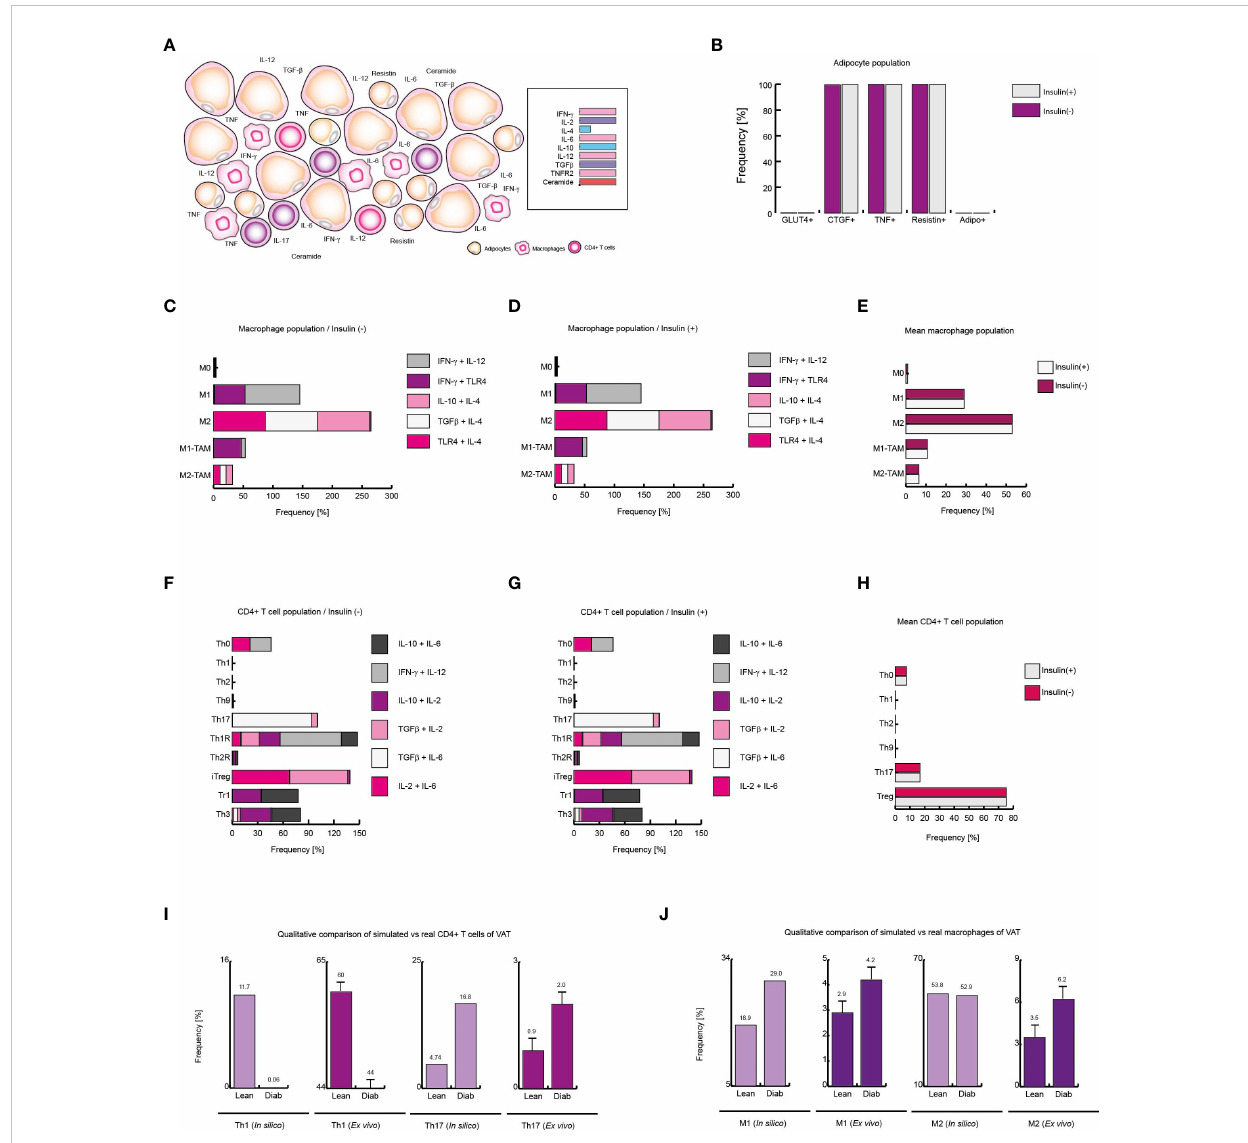
FIGURE 7 Extracellular ceramide inhibits Th1 response in diabetic patients. (A) Schematic representation of the simulated conditions within diabetic patients VAT, (B) Distribution of adipocyte-phenotypes with and without insulin. (C) Distribution of macrophage-phenotypes in absence of insulin, and (D) in presence of insulin. (E) Average behavior of macrophage phenotype distribution. (F) Distribution of CD4+ T cells without insulin, (G) and with insulin. (H) Average distribution of CD4+ T lymphocytes phenotypes. (I) Simulated Th1 and Th17 populations compared to ex vivo frequencies of such phenotypes. (J) Simulated M1 and M2 populations versus their ex vivo frequencies. The values presented for panels (I, J) was adapted from (35) and (9) respectively. These results suggest that extracellular ceramide inhibits Th1 response and avoids Treg inhibition due to insulin, as it was observed in obese